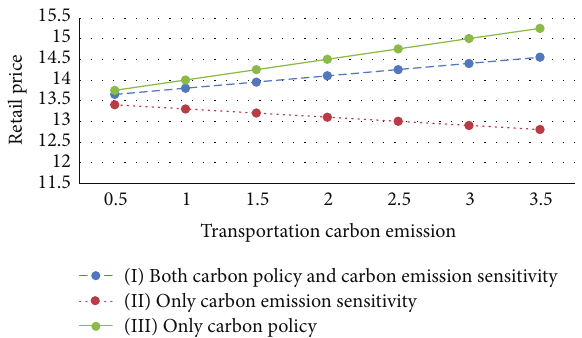
Figure 7: Effect of carbon emission on order quantities.